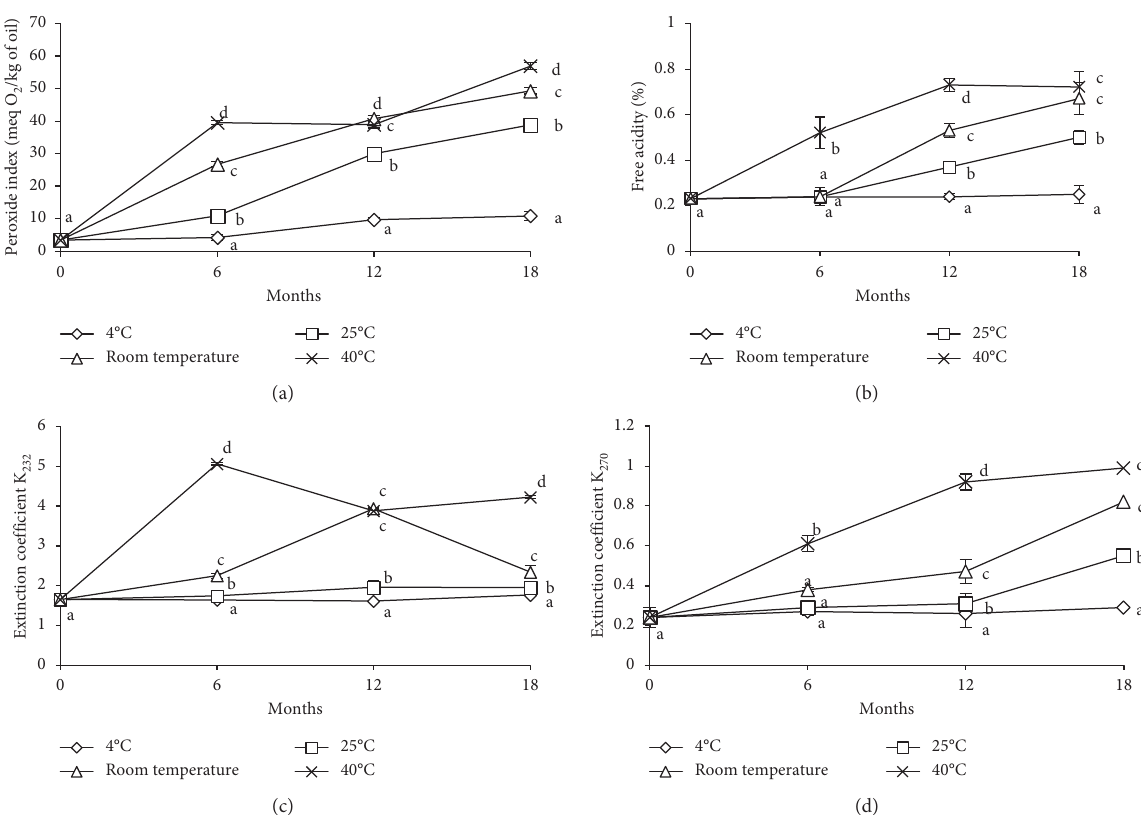
Figure 1: Evolution of quality parameters of prickly pear seeds oil during storage at various temperatures: 4 ° C, 25 ° C, 40 ° C, and uncontrolled room temperature. (a) Peroxide index. (b) Free acidity. (c) Specific extinction coefficient K 232 . (d) Specific extinction coefficient K 270 . The error bars represent the standard deviation of three replicates. Means with the same letter for the same storage time are not significantly different according to Student–Newman–Keuls test at P <